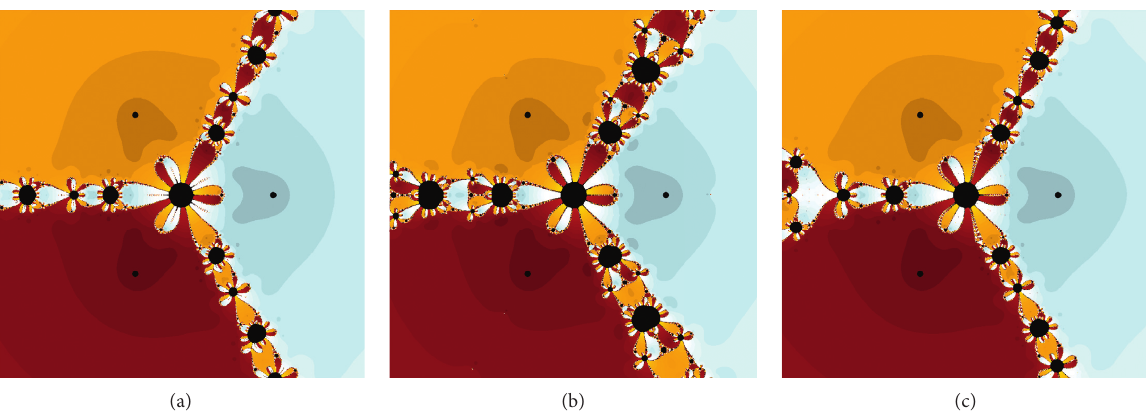
Figure 2: Basins of attraction associated with the polynomial p Algorithm 3.